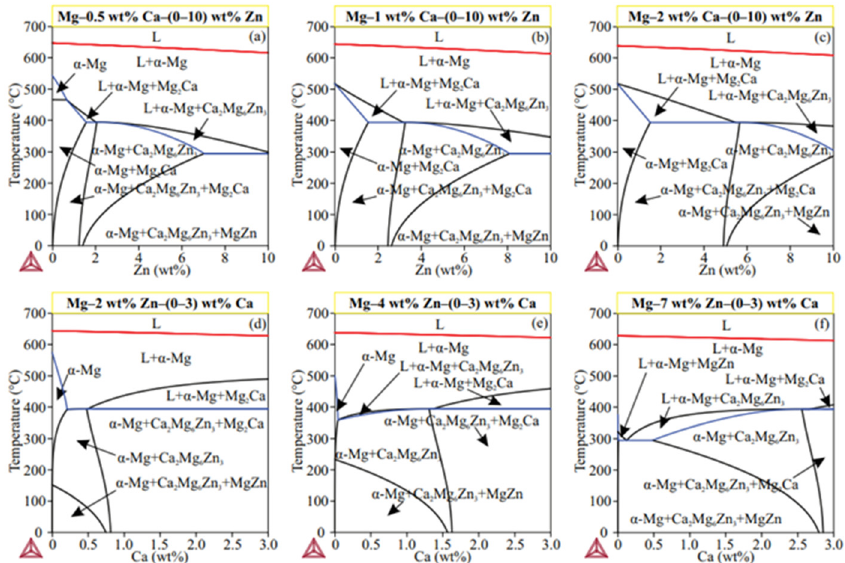
Figure 4. Polythermal cross sections of Mg–Zn–Ca phase diagrams calculated: ( a ) Mg–0.5 wt% Ca–(0–10) wt% Zn; ( b ) Mg–1 wt% Ca–(0–10) wt% Zn; ( c ) Mg–2 wt% Ca–(0–10) wt% Zn; ( d ) Mg–2 wt% Zn–(0–3) wt% Ca; ( e ) Mg–4 wt% Zn–(0–3) wt% Ca; ( f ) Mg–7 wt% Zn–(0–3) wt% Ca. Reprinted